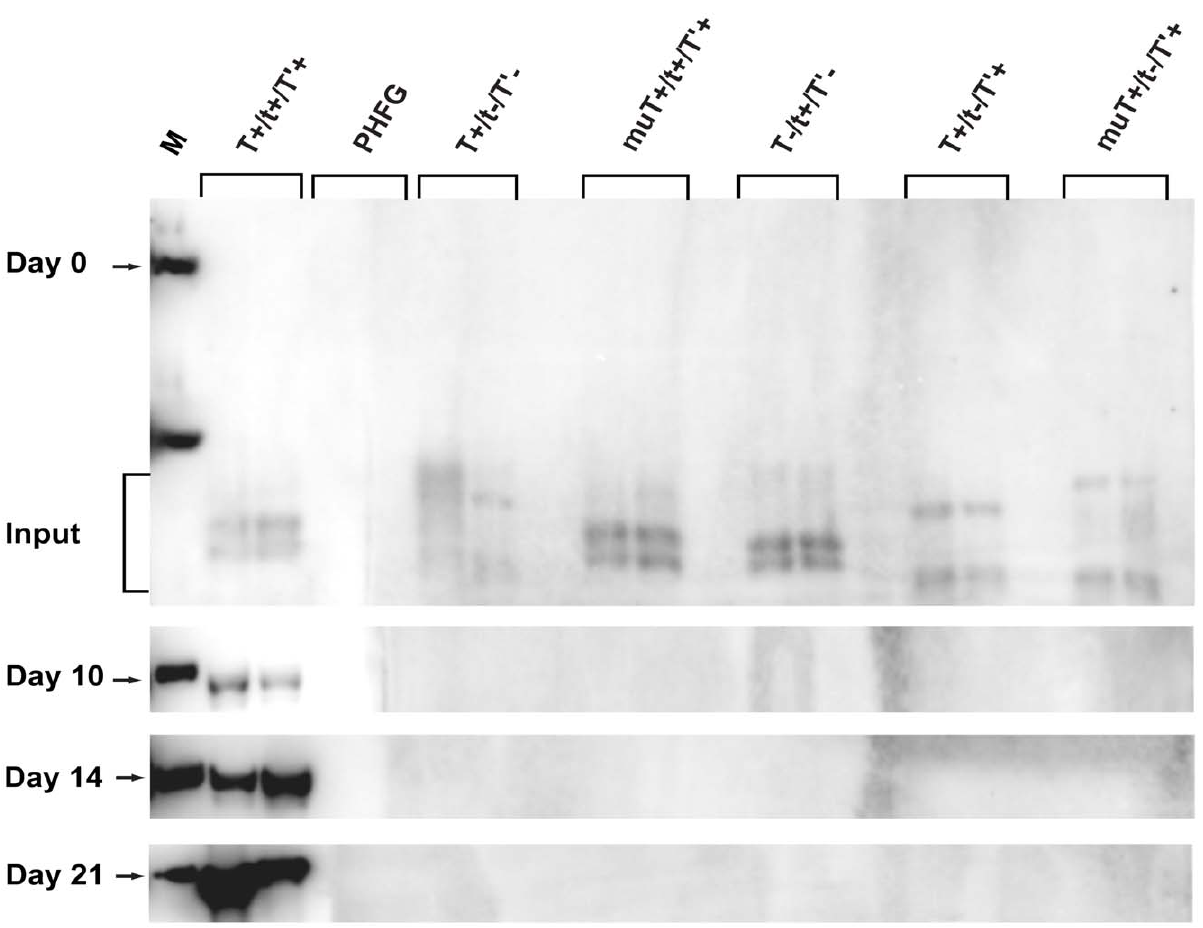
Figure 5. Replication efficiencies of DNA constructs expressing combinations of JCV early proteins. PHFG cells in 60 mm plates were transfected in duplicate with 400 ng of wild type (T + /t + /T’ + ) or mutant (T + /t 2 /T’ 2 , muT + /t + /T’ + , T 2 /t + /T’ 2 , T + /t 2 /T’ + , or muT + /t 2 /T’ + ) JCV genomes. At each time point, viral DNA was extracted by the Hirt procedure [39], purified, digested with Dpn I and Eco RI, electrophoresed on a 0.8% agarose gel, transferred to nitrocellulose membranes and hybridized to a [P 32 ]dCTP-labeled JCV DNA probe. Bands were visualized with a Typhoon phosphorimager and quantitated with ImageQuant software. The marker (M) shown in the first lane of each blot is 1 ng of linear JCV DNA (5130 bp). The duplicate, independent samples representing each DNA construct were analyzed, and the position of Dpn 1-resistent replicating genomes on the Southern blots is denoted by an arrow at days 10, 14 and 21 p.t. Dpn 1- and Eco RI-sensitive input DNAs are noted at the day 0 time point. Hirt extracts of uninfected PHFG cells (PHFG) were subjected to the same Dpn1